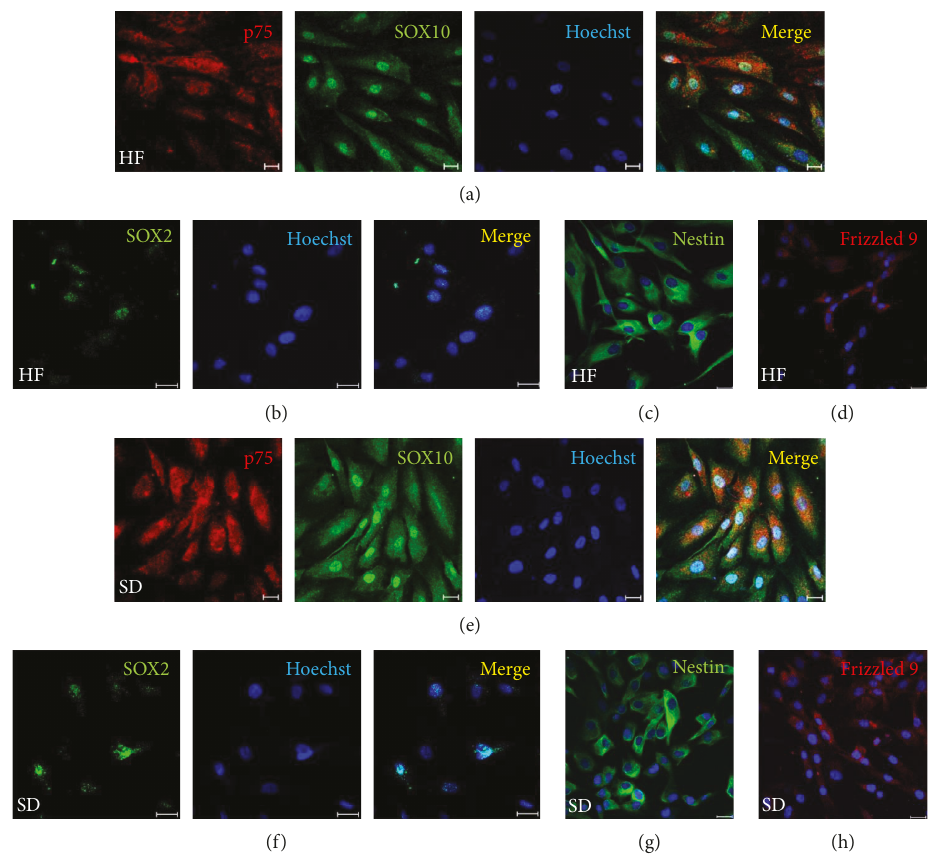
Figure 2: Cells isolated from hair follicle and skin dermis express the key markers of NCSCs. (a – d) HF NCSC at passage 1; (e – h) SD NCSCs at passage 1. Results of immunocytochemical analysis. (a, e) p75/CD271 (red), SOX10 (green). (b, f) SOX2 (green). (c, g) NESTIN (green). (d, h) FRIZZLED-9/CD349 (red). The nuclei were stained with Hoechst 33342 dye. Scale bar: 20 μ